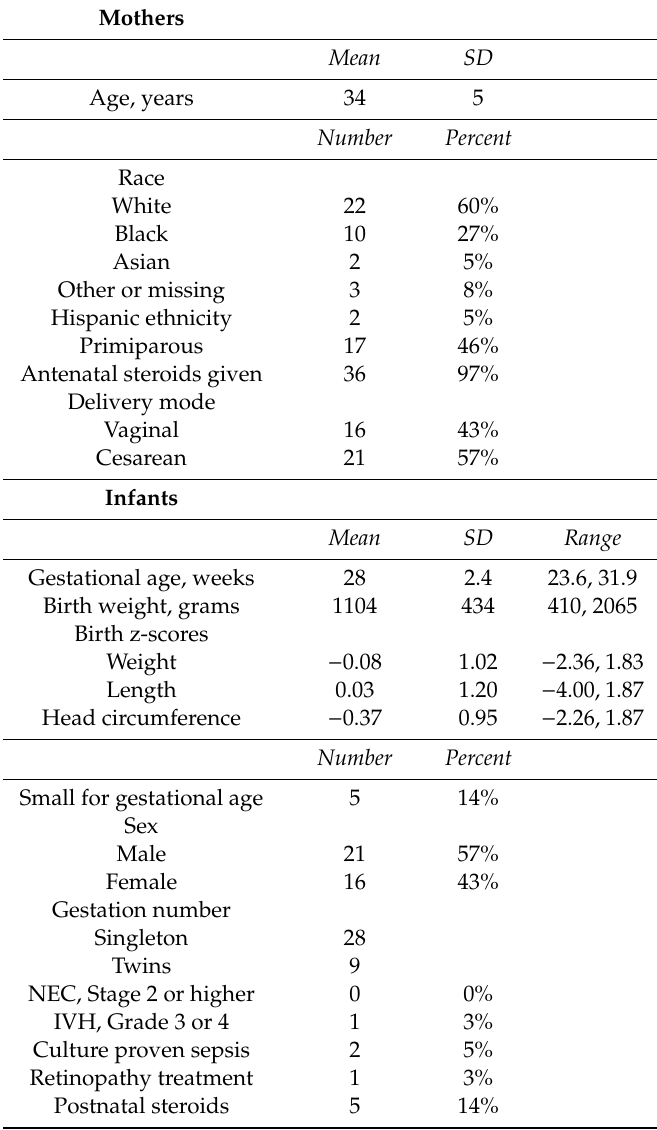
Table 1. Participant characteristics ( n =